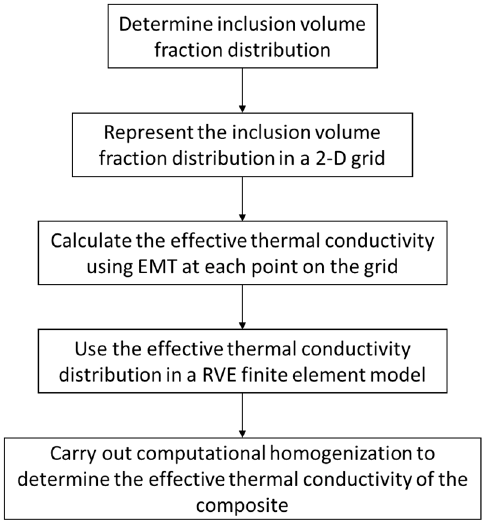
Figure 5. Two-scale methodology for effective thermal conductivity estimation.